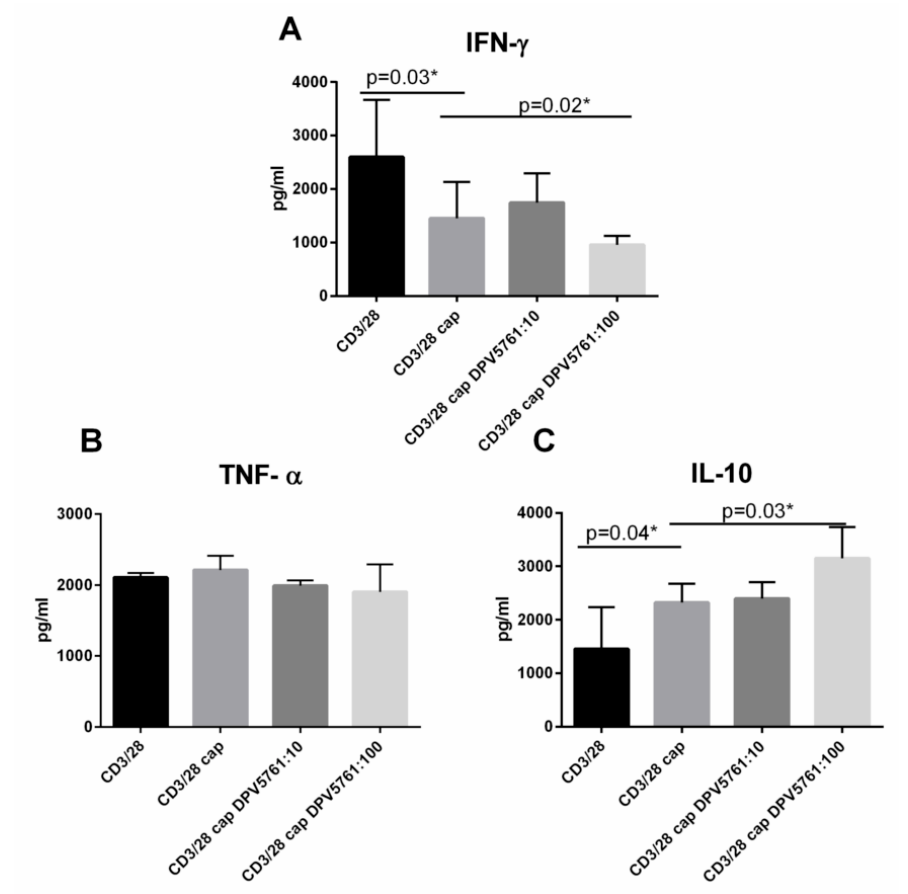
Figure 6. ( A – C ) DPV576 modulated cytokine secretion of TRPV1 agonist, capsaicin, in CD4 + T cells. 6 Capsaicin + anti CD3/CD28 activated CD4 + T lymphocytes were exposed to DPV576 for 24 h. Secretion of cytokines was determined by ELISA. Bar graph depicts the level of: ( A ) IFN- γ , ( B ) TNF- α , and ( C ) IL-10. Data is mean ± S.E. of three